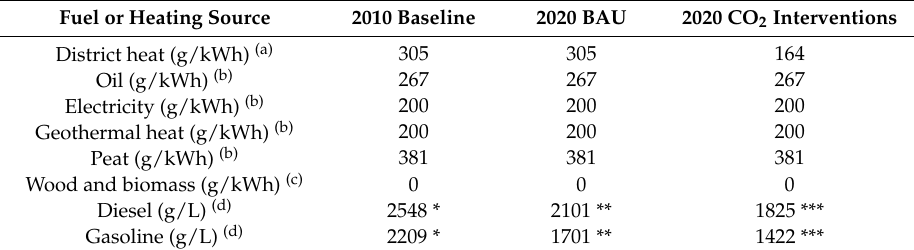
Table 4. Fossil CO 2 emission factors for different sources of heat and for